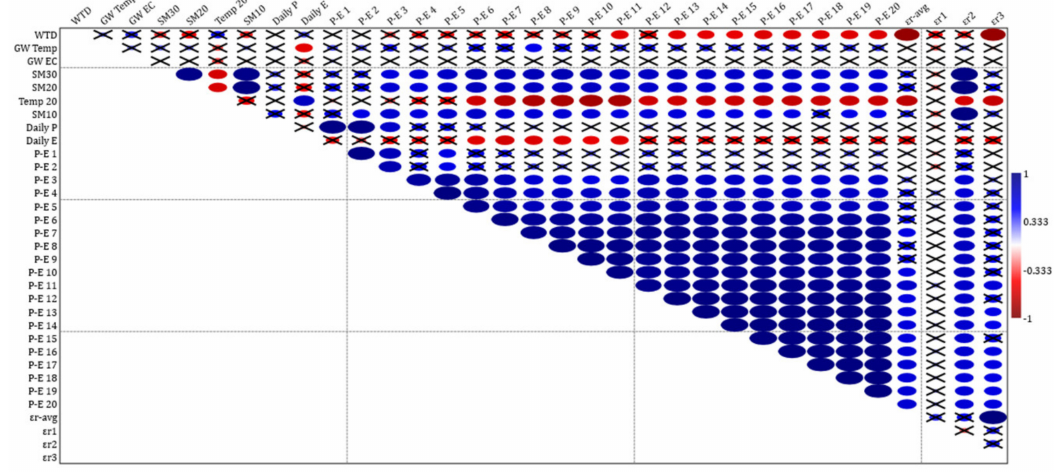
Figure 11. Pearson’s correlation coe ffi cient ( r ) of 33 variables tested ( p > 0.05 are